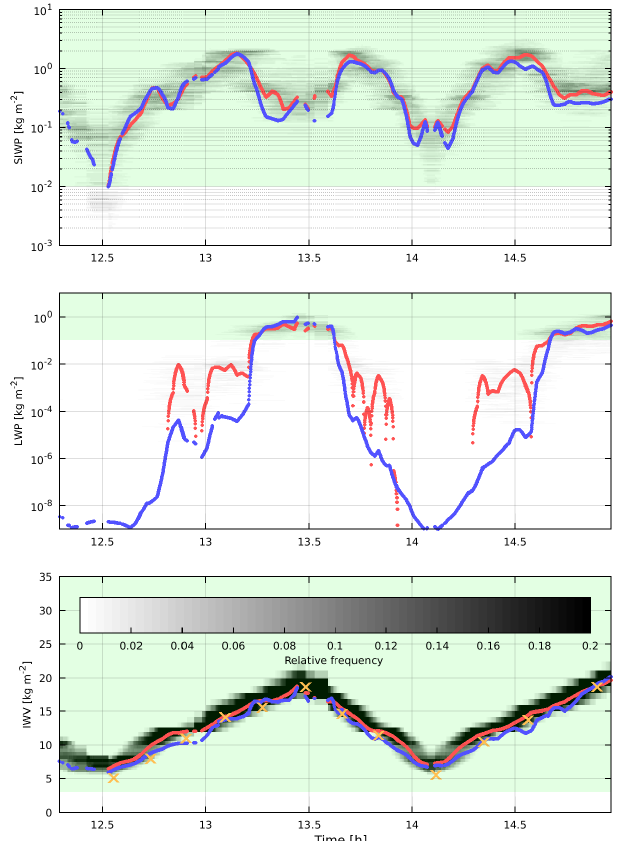
Figure 9. Time series of the retrieved SIWP, LWP, and IWV from simulated flight B897. The time series of the retrieved SIWP, LWP, and IWV are shown as blue lines. The time series of the ICON model SIWP, LWP, and IWV for the time and location of the FAAM during flight B897 are shown as red lines. Time series of histograms of the ICON model SIWP, LWP, and IWV are plotted as grey shades underneath; see text for details. The green shaded areas marks the range where the retrieval is offset-free according to Sect. 4. The or- ange crosses indicate the IWV from the dropsonde